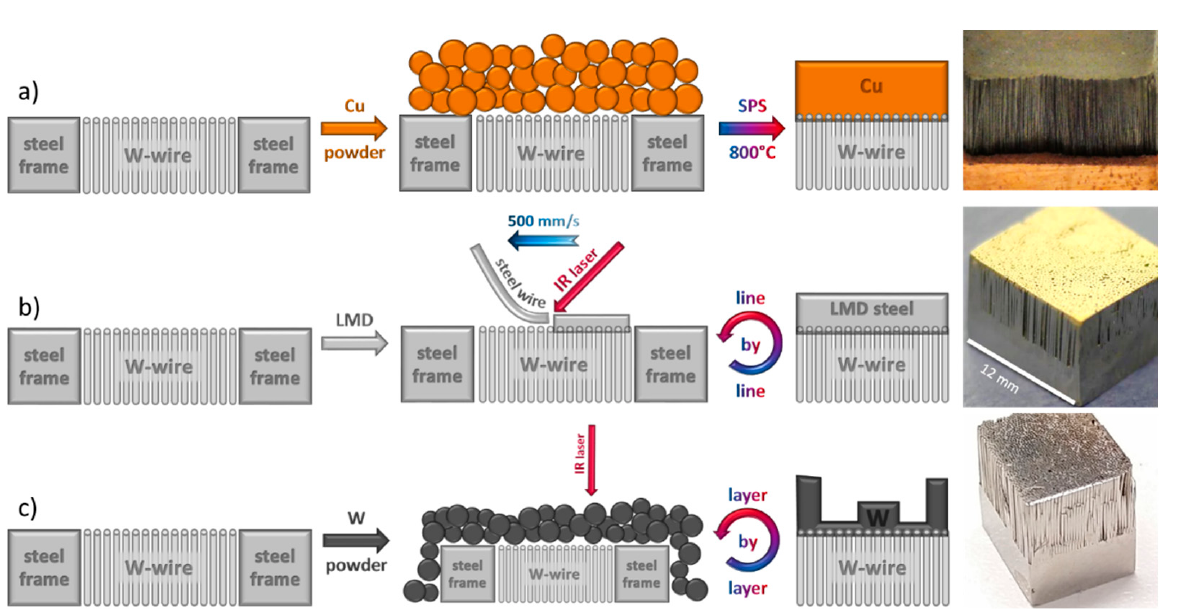
Figure 3. Developed joining techniques to create a µ-brush with high potential for up-scaling in the future. For Cu spark plasma sintering ( a ); for steel laser metal deposition ( b ); and for W selective laser melting, which also enables advanced structures ( c ).